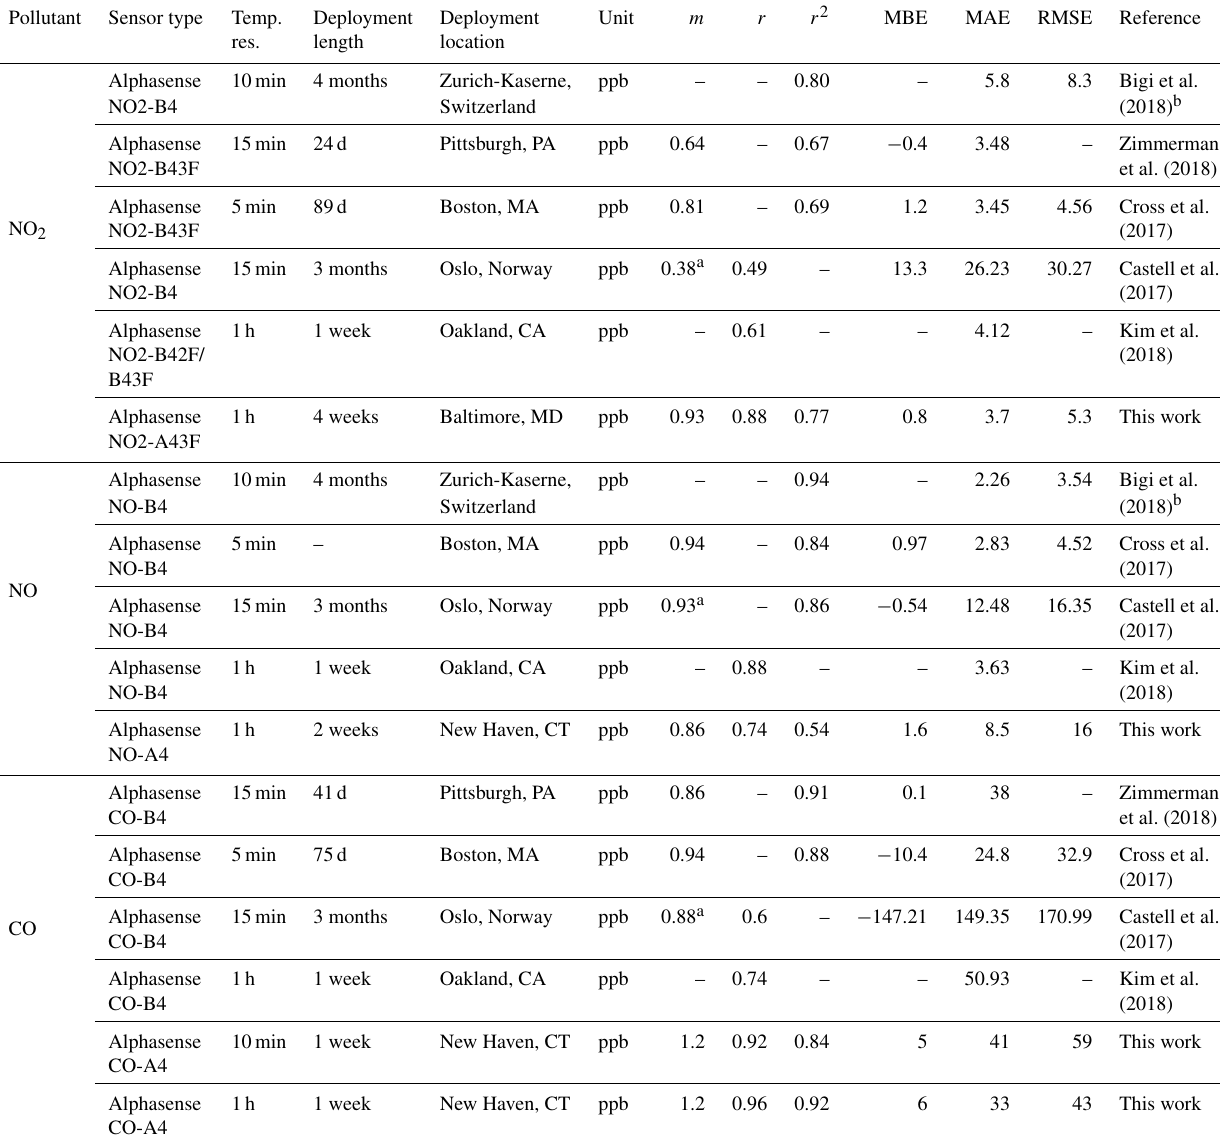
Table 3. Summary of statistics and comparison of the SEARCH stationary multipollutant monitor to several recent literature field studies (NO 2 , NO, and CO). Dashes indicate data not reported or readily accessible for a given